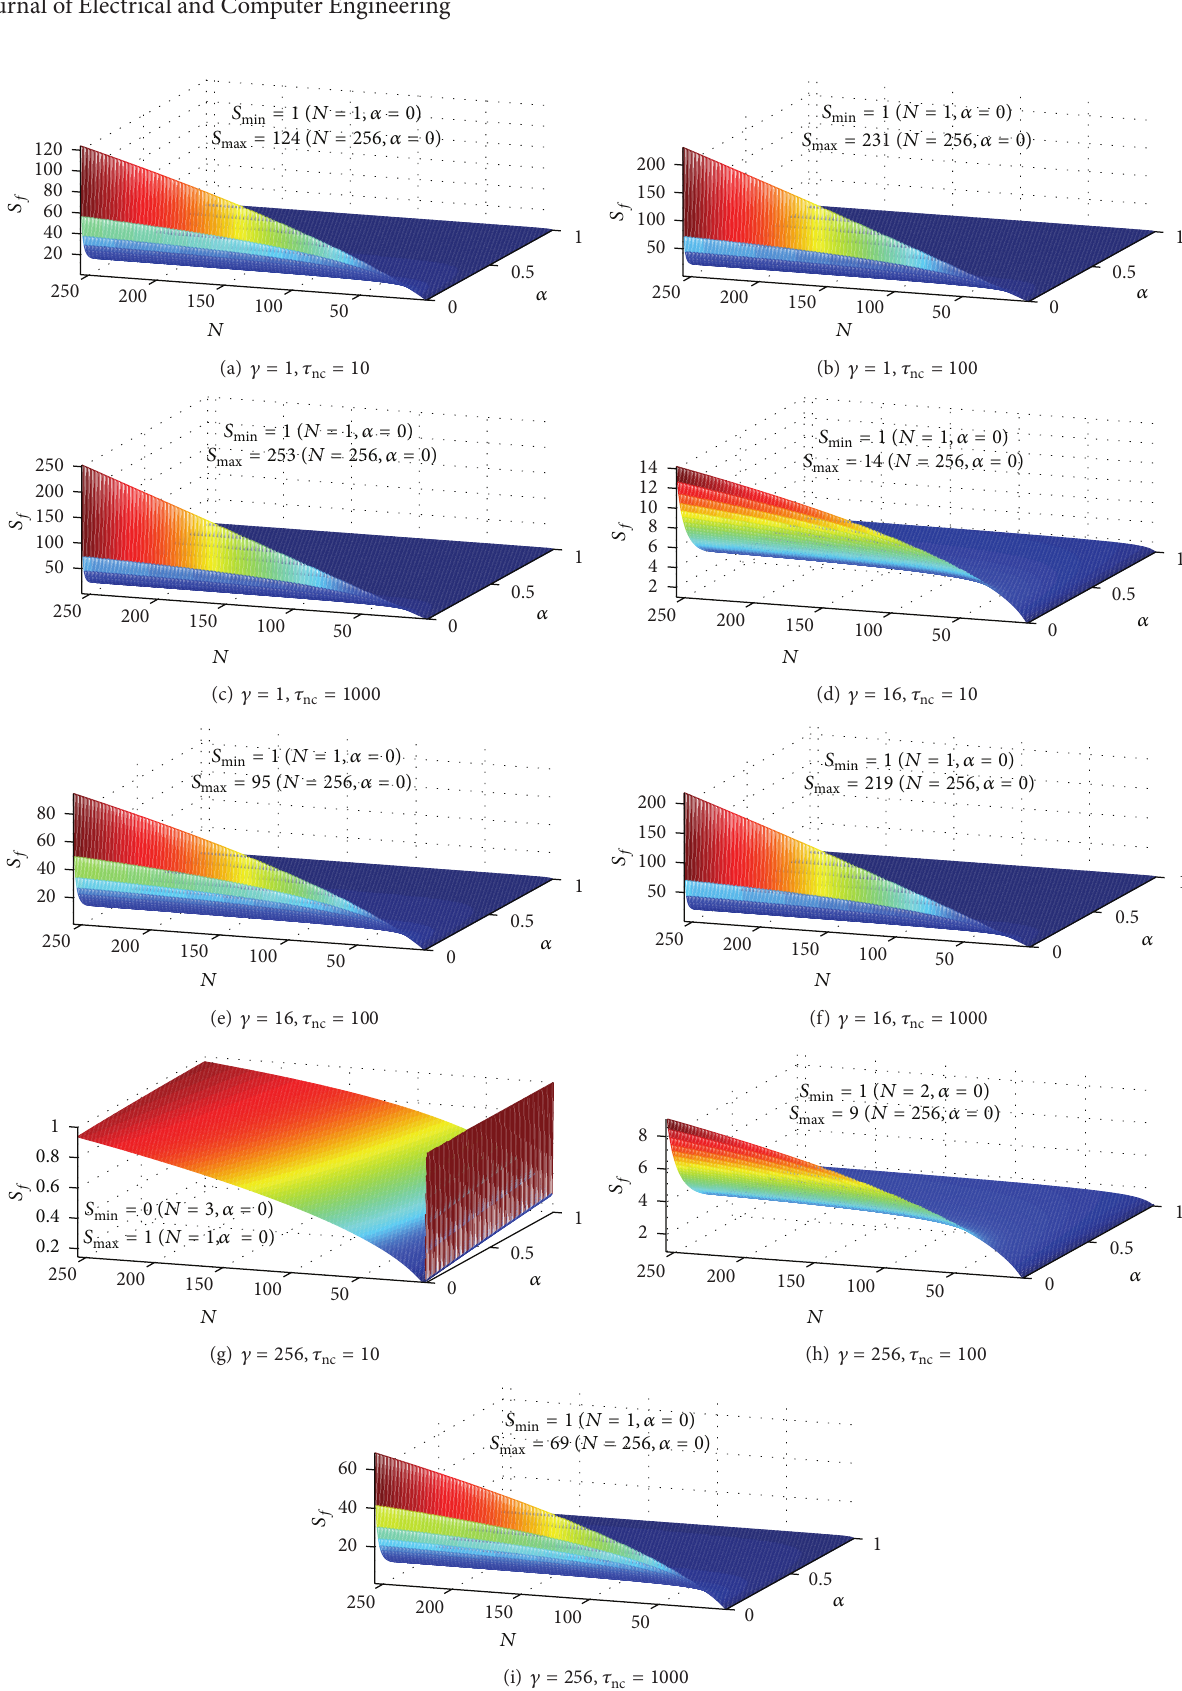
Figure 6: Performance trends under uniform traffic